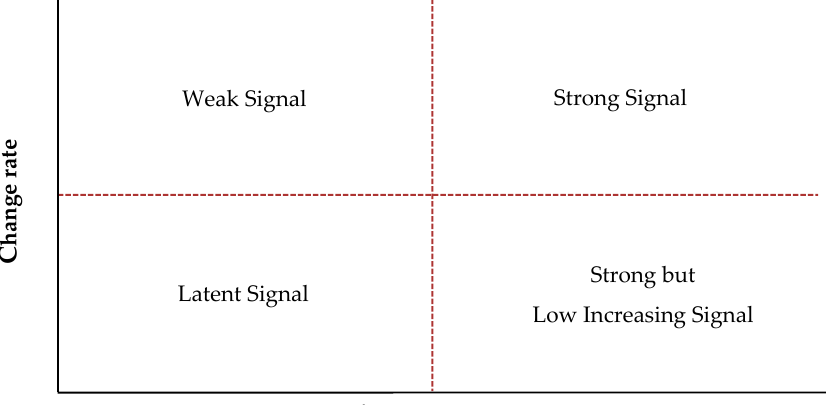
Figure 1. Map of Future Signals.